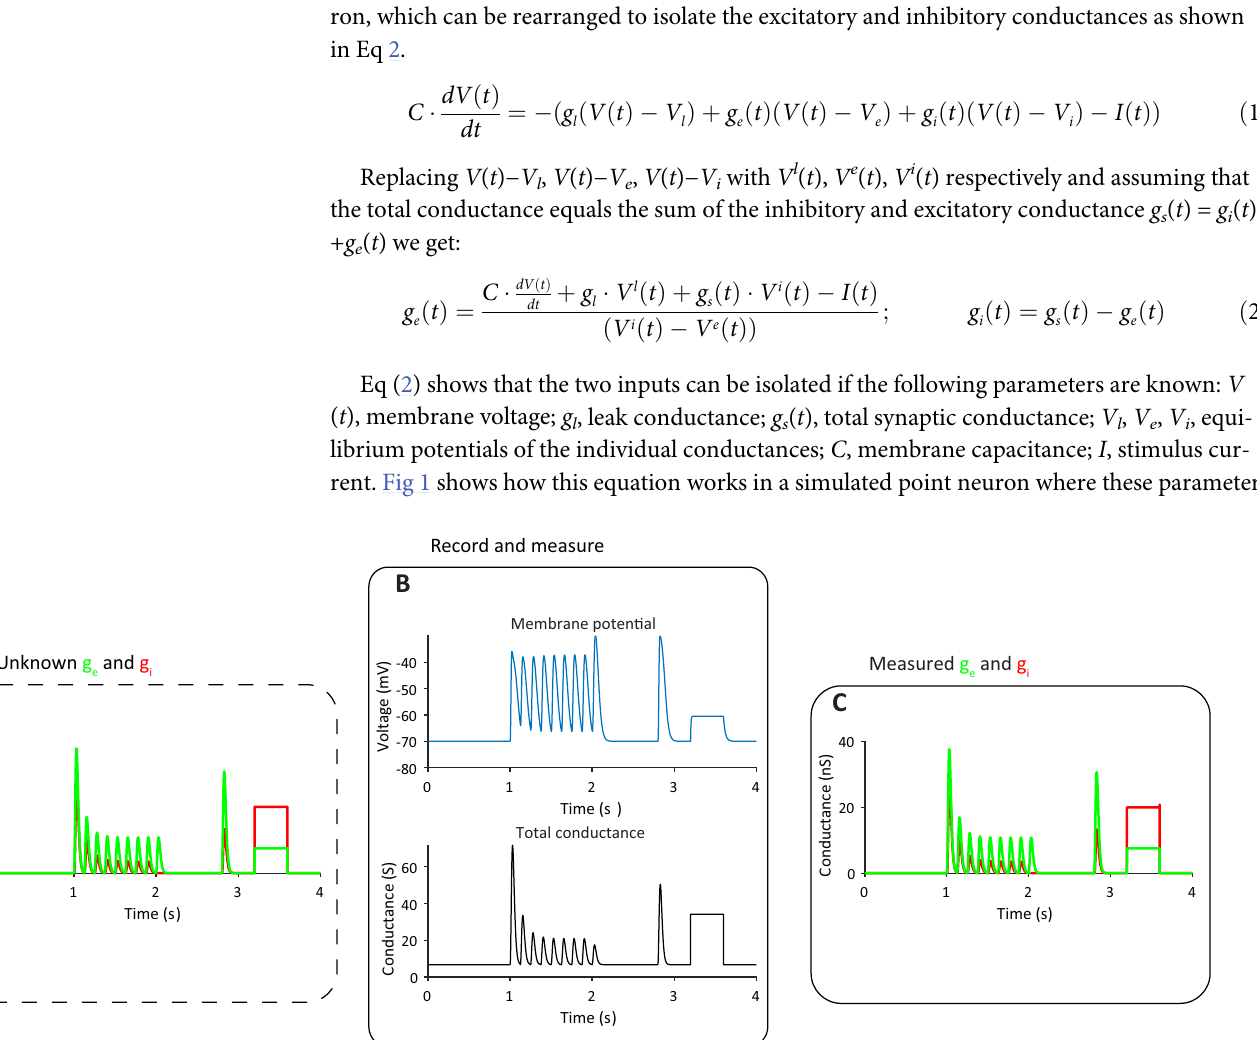
PLOS Computational Biology | https://doi.org/10.1371/journal.pcbi.1009725 December 28,